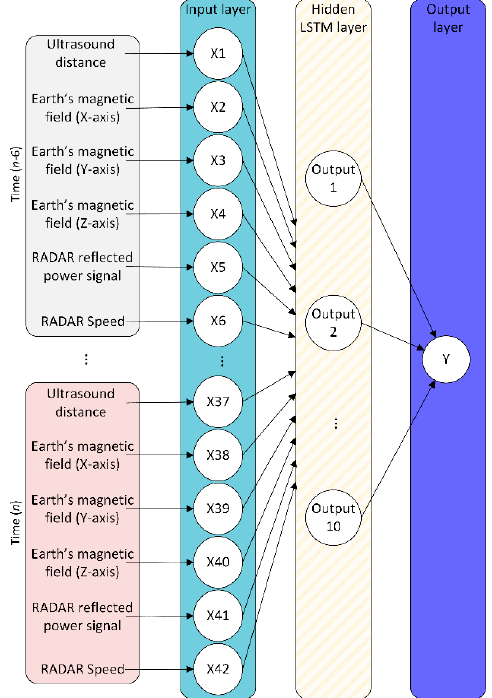
Figure 3. Long short-term memory (LSTM)-based neural network structure.